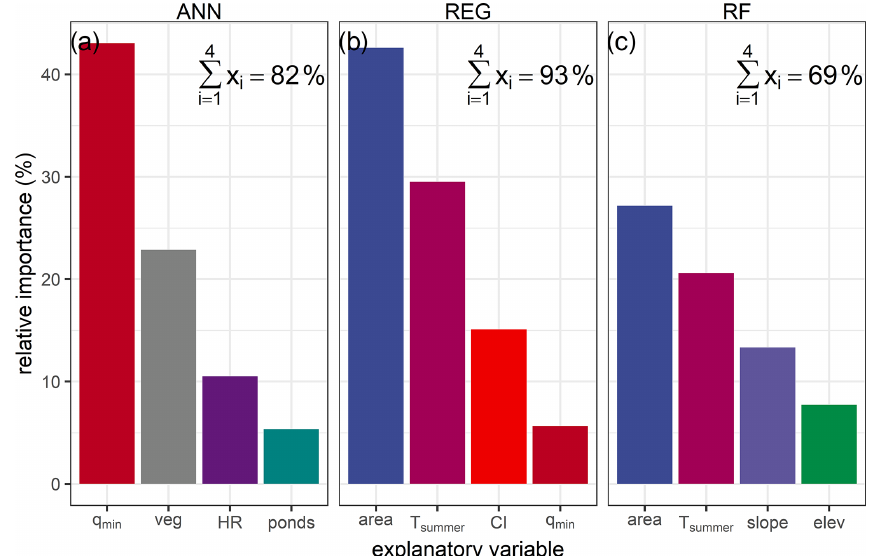
Figure 4. Relative importance of top four explanatory variables calculated in cross-validation for the estimation of T p with the models: (a) ANN, (b) REG, and (c) RF. To compare the relative importance of each variable for each model, all variables were centered and scaled. Text in the upper right of each panel refers to the sum of the relative importance of the first four explanatory variables in each model; colors indicate the explanatory